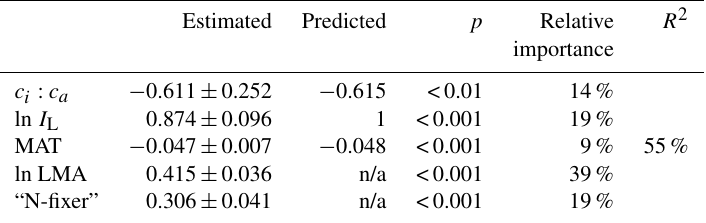
Table 1. Linear regression coefficients for ln N area (gm − 2 ) as a function of c i : c a (from δ 13 C), ln (mean canopy PAR, I L ) (µmolm − 2 s − 1 ) , MAT ( ◦ ), ln LMA (gm − 2 ), and the factor “N-fixer” at species level. Estimated Predicted p Relative R 2 importance